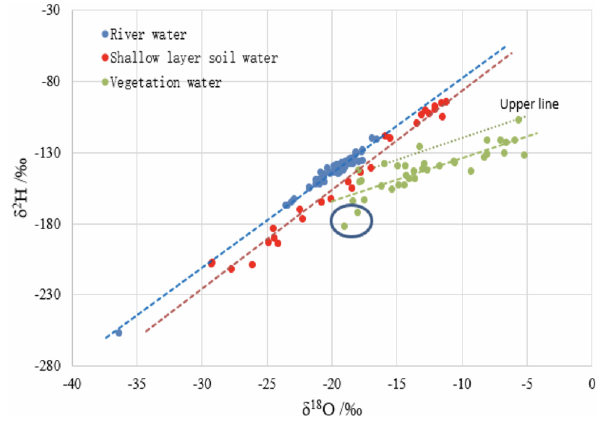
Figure 9. Isotopes of the soil and vegetation